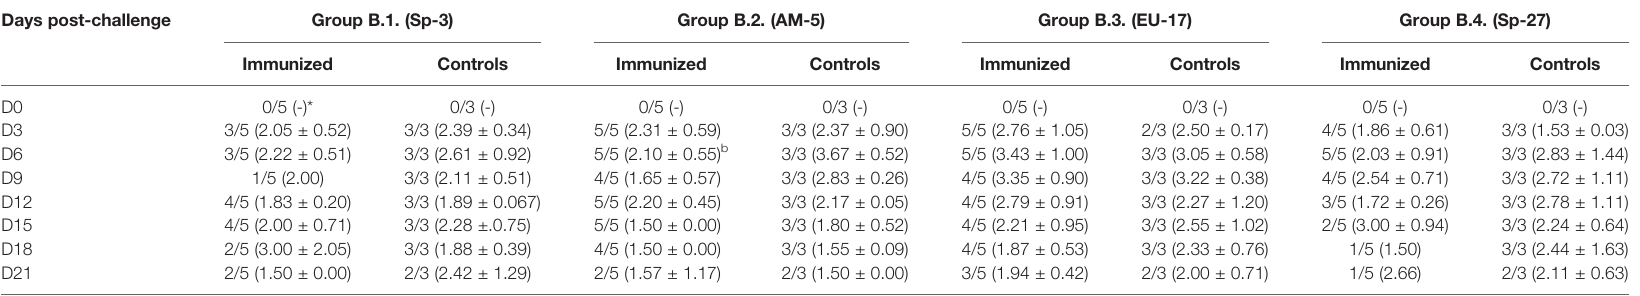
TABLE 4.1 | Virus isolation from serum samples collected in Experiment B (pigs immunized with EU-11a).